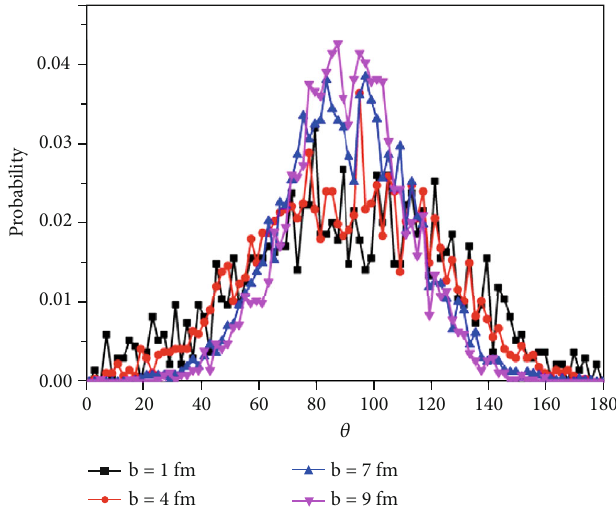
Figure 7: The dependence of angular distributions about Θ + 197 Au system at an energy of 15MeV/nucleon.